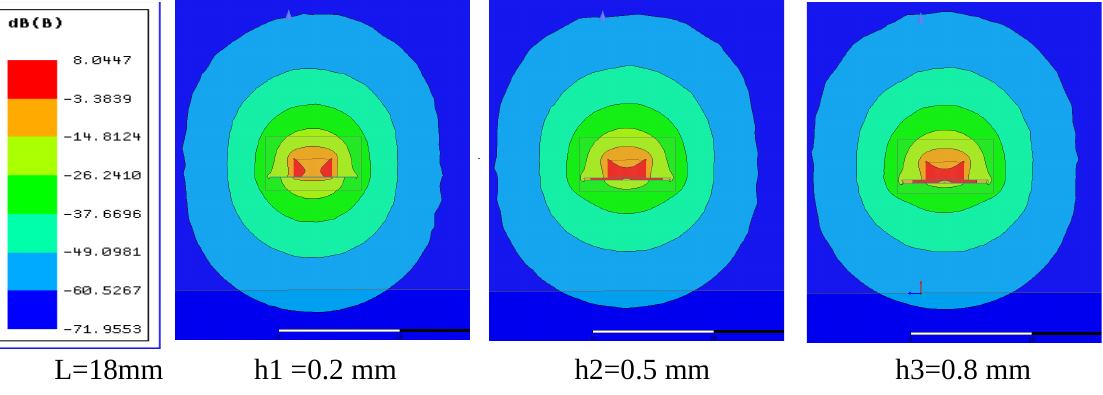
Figure 7. MO vs. increasing reactive-part thickness: h1 = 0.2 mm, h2 = 0.5 mm, and h3 = 0.8 mm, with a constant surface-area value equal to 18 mm × 18 mm.